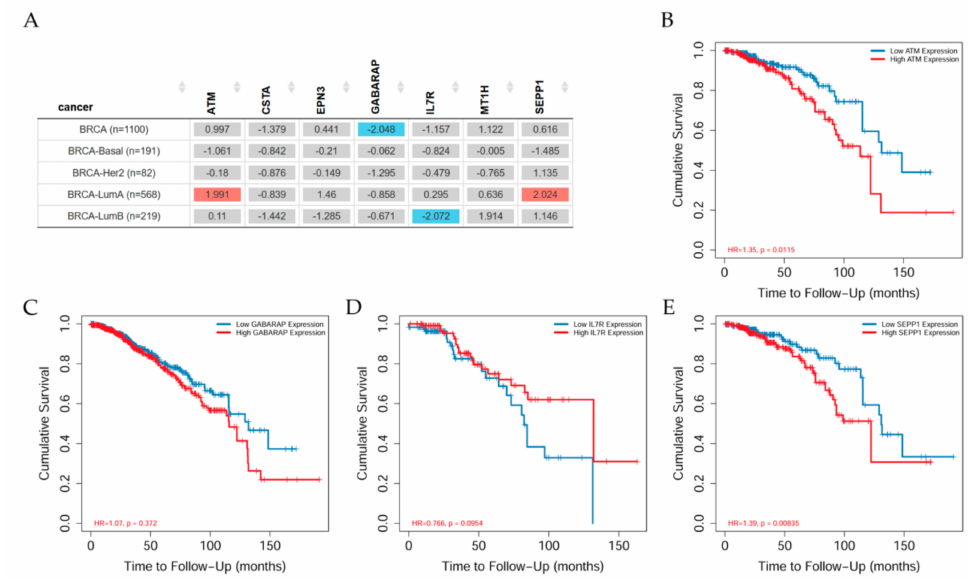
Figure 4. ( A ) Gene expression across various BRCA patient types. KM curves of the genes where the cumulative survival differences in low and high gene expression can be appreciated. The KM curves correspond to the cumulative survival and time to follow up (months) of ( B ) ATM, ( C ) GABARAP, ( D ) IL7R, ( E ) SEPP1 at low and high expression given by cumulative survival and time to follow-up. According to results related to gene risk in the web based on Z-score, studies indicated that: ATM had increased risk ( p < 0.05) in BRCA-LumA patients; a non-significant ( p < 0.05) difference in risk with CSTA in all BRCA, BRCA-basal, BRCA-Her2, BRCA-LumA, BRCA- LumB patients; a non-significant ( p < 0.05) risk with CSTA and EPN3 in all BRCA, BRCA- basal, BRCA-Her2, BRCA-LumA, BRCA-LumB patients; GABARAP had decreased risk ( p < 0.05) in BRCA-basal, BRCA-Her2, BRCA-LumA, BRCA-LumB patients; non-significant ( p < 0.05) difference in risk MT1H in all BRCA, BRCA-basal, BRCA-Her2, BRCA-LumA, BRCA-LumB patients; and finally, an increased risk ( p < 0.05) in BRCA-LumA patients. Studies on gene survival from the web on breast cancer patients show the gene outcome module used to that explore the clinical relevance of low and high ATM gene expression across various types of BRCA. Gene survival used the Cox proportional hazard model to evaluate the outcome significance of gene expression. The KM curves of ATM at low and high expression is given by cumulative survival and tie to follow-up (months). Results indicated that ATM and SEPP1 genes induced significant ( p < 0.05) increased risk in BRCA-LumA patients than other type of breast cancer patients while GABARAP gene induced significant ( p < 0.05) decreased risk in all BRCA patients, but IL7R in only BRCA- LumB patients. On the other hand, there was non-significant difference in CSTA, EPN3 and